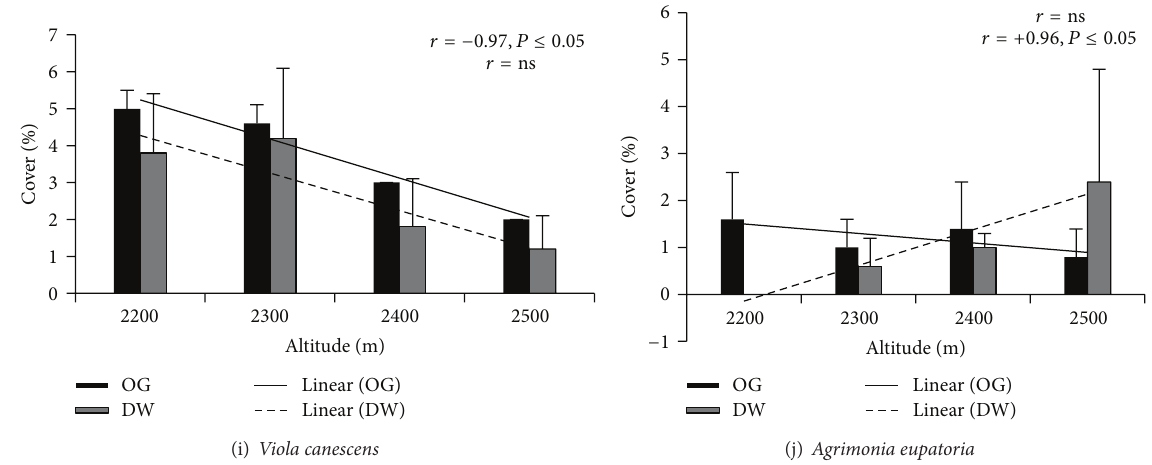
Figure 5: Cover of individual medicinal plant species in old-growth (OG) forest and derived woodland (DW) along altitude. ∗ represents significant difference between the two forest-use types. 𝑟 represents Spearman correlation. ns indicates no significant